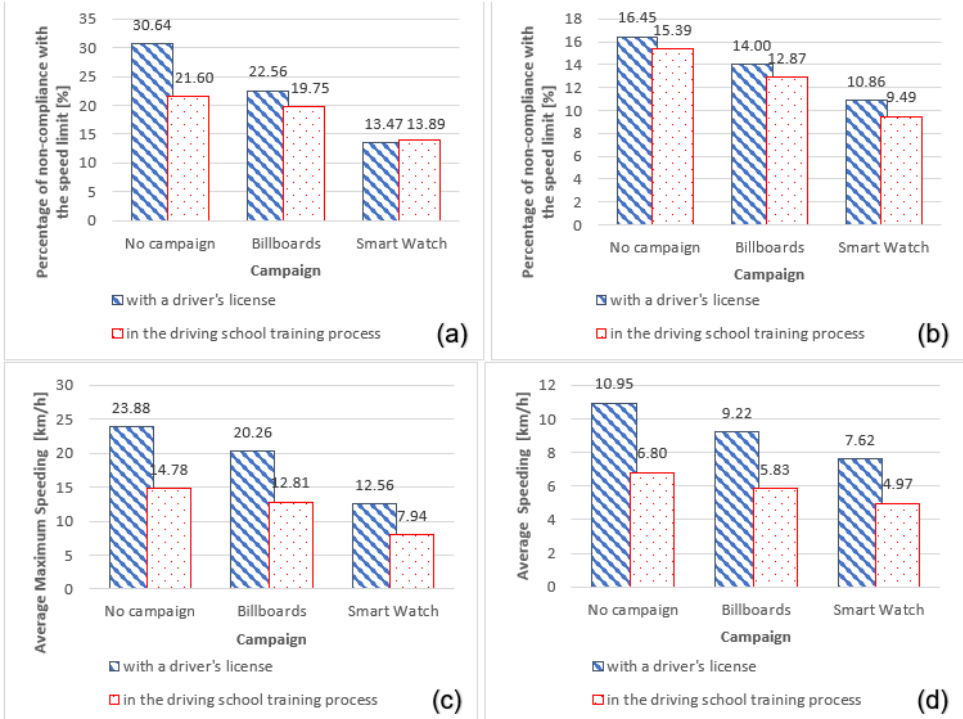
Figure 4. Results for respondents who have a driver’s license and for respondents who are in the process of training in driving schools for: ( a ) PncSL; ( b ) PST; ( c ) AMS; and ( d ) AS.